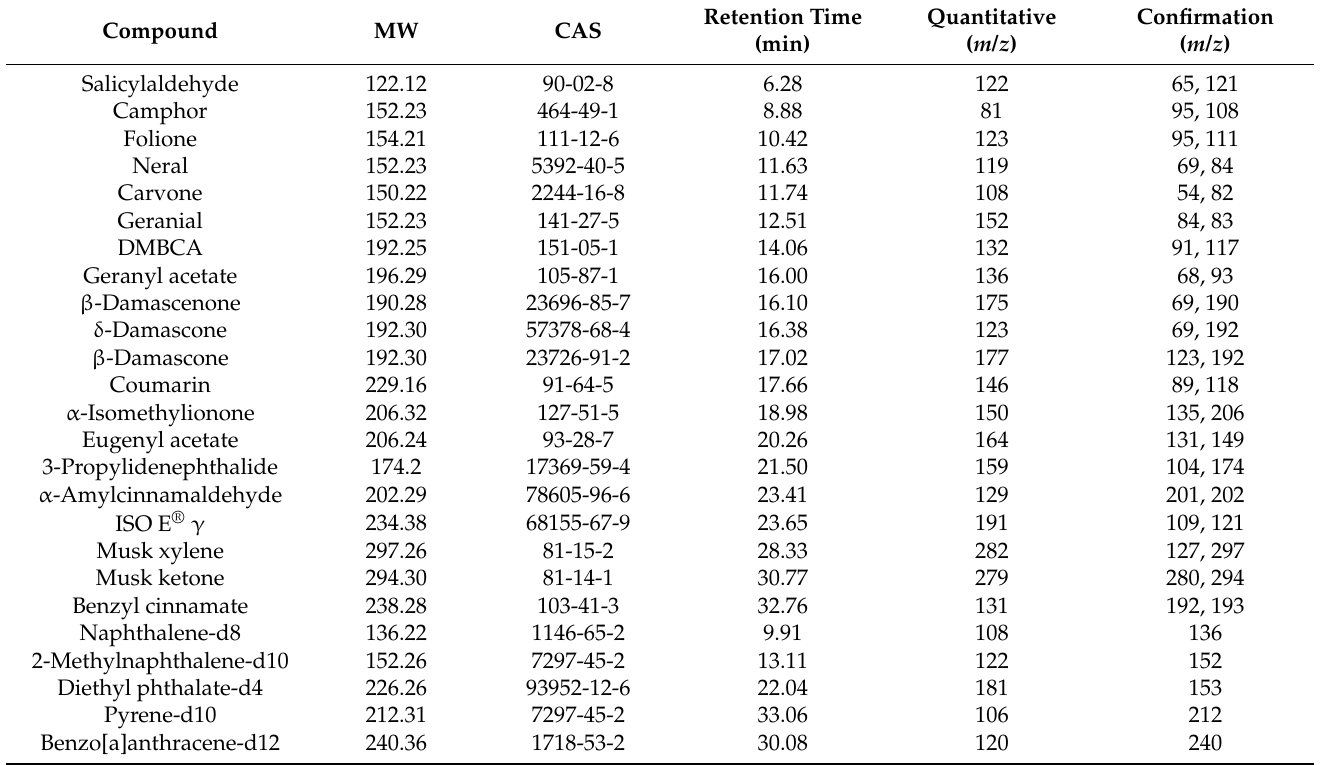
Table 1. Molecular weight (MW), CAS number, retention time, and m / z ratios were used for the fragrance